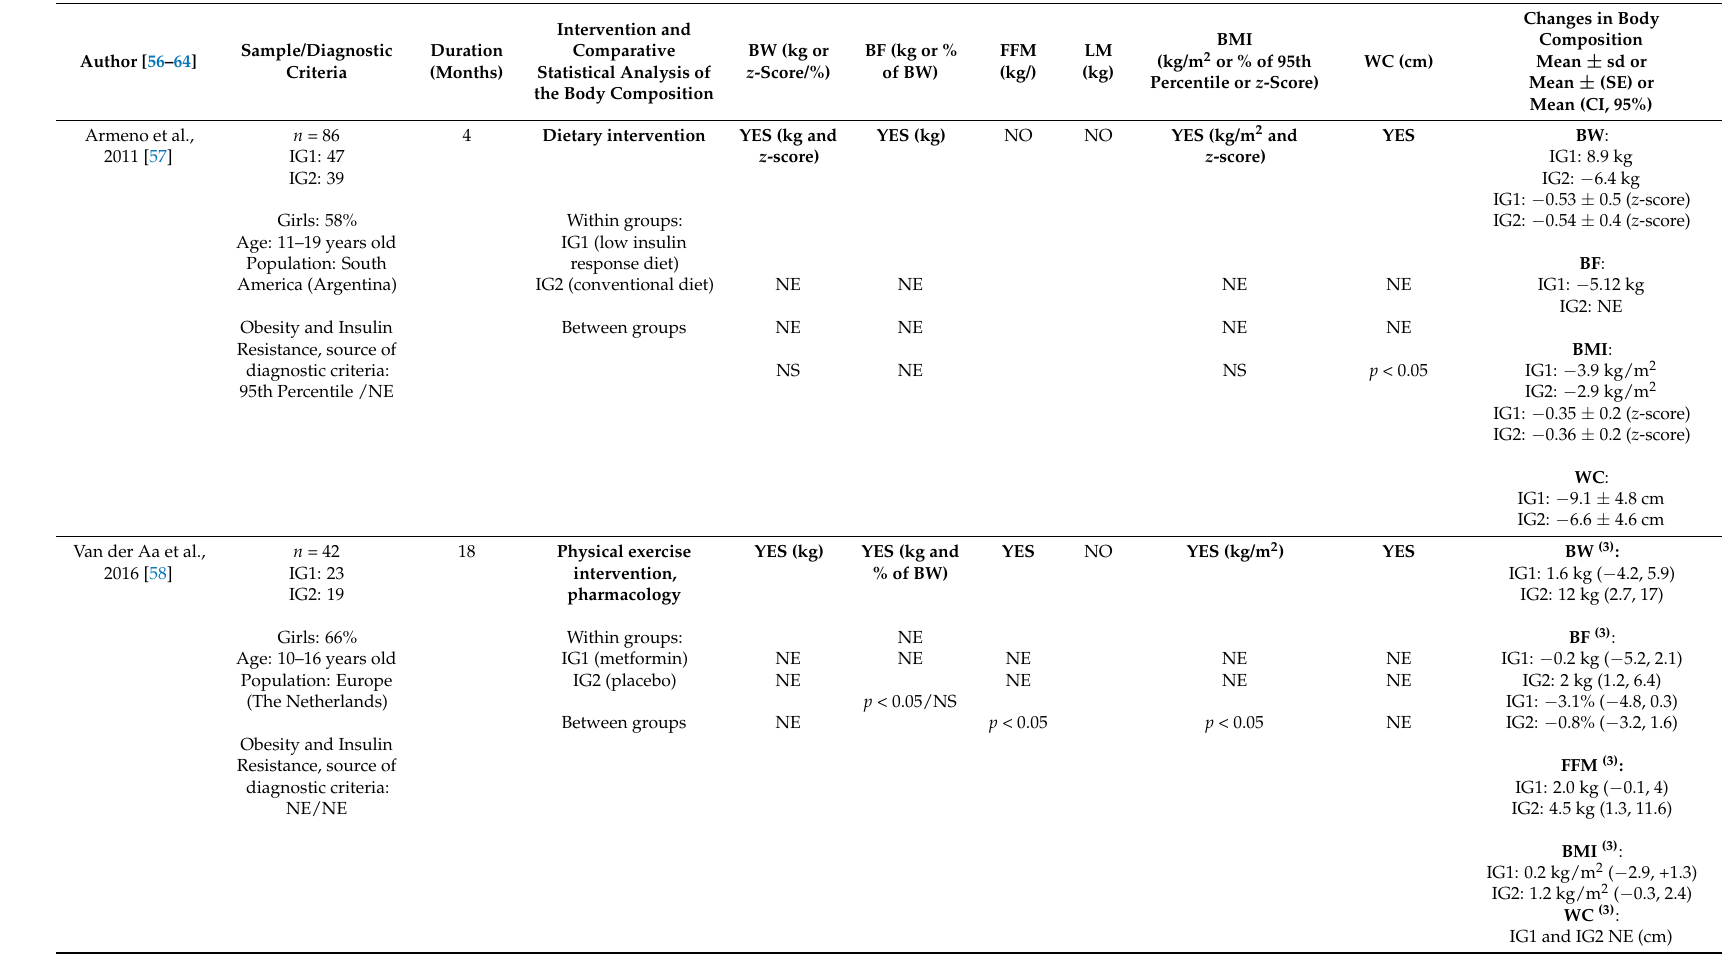
Table 6. Characteristics of included randomized trials in children and